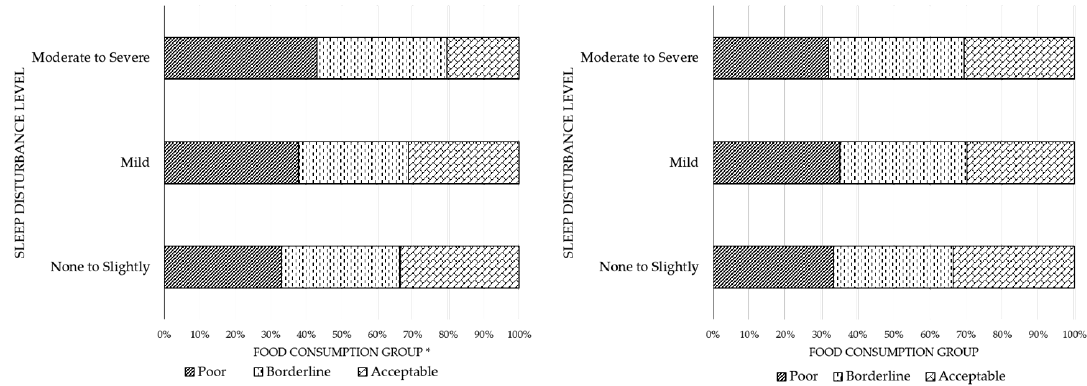
Figure 1. Prevalence of sleep disturbance among men (left) and women (right) by food consumption group. Indonesia Family Life Survey (IFLS) 2014 data were used in the analysis. * Significance: p < 0.05.